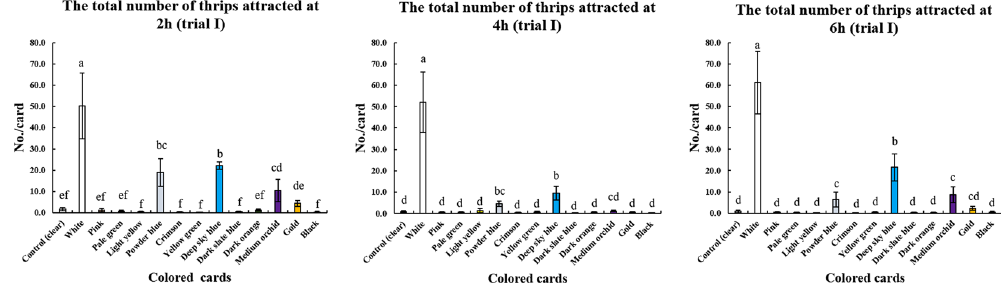
Figure 1. The attractiveness of different colored cards to thrips at 2 h, 4 h and 6 h (trial I) (mean ± SEM).